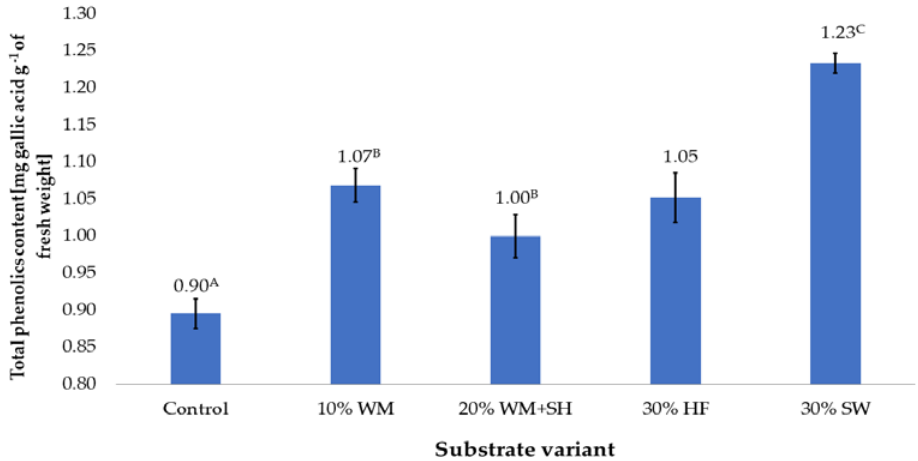
Figure 1. The total content of polyphenols in raspberry fruits, depending on the substrate used (n = 36). Note: Significant differences between the results, depending on the substrate variant used, are marked with different letters. Signific ant level at p < 0.05. Key: Control—100% coconut fibre; 10% WM — 90% coconut fibre + 10% fragmented wood material; 20% W M + SH—80% coconut fibre + 10% fragmented wood material + 10% biochar from sunflower husk; 30% HF —70% coconut fibre + 30% hemp fibre; 30% SW —70% coconut fibre + 30% sheep wool .